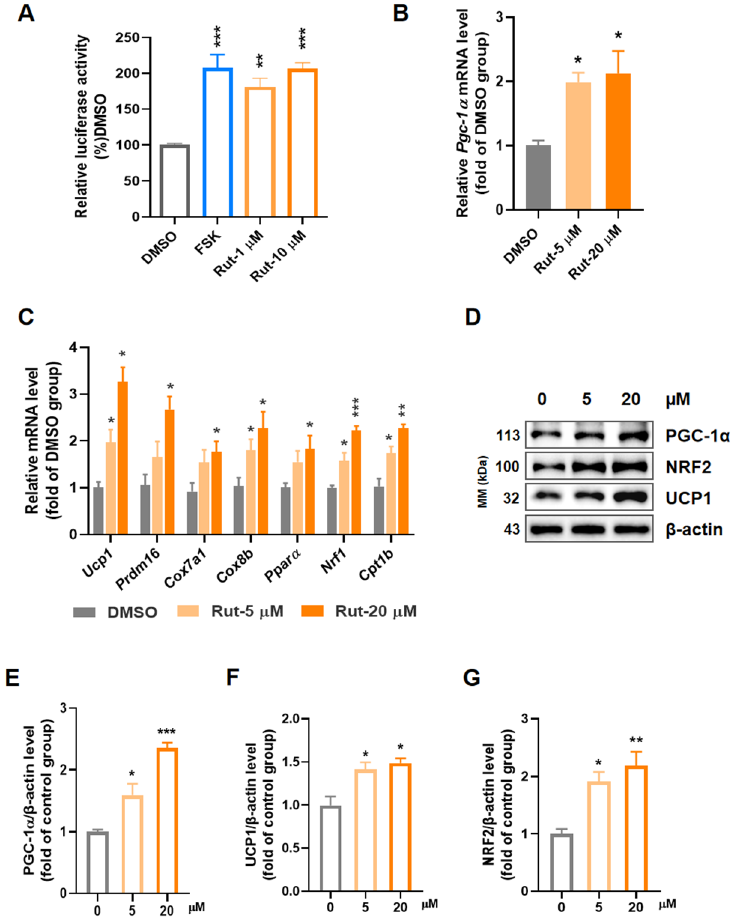
Figure 1. Rut increases expression of PGC-1 α and drives the thermogenesis program. ( A ) The screening result of Rut in activating PGC-1 α . ( B ) Effect of Rut on activating PGC-1 α in C3H10-T1/2. ( C ) RT-qPCR analysis of genes indicated in C3H10-T1/2. ( D ) Expressions of protein indicated in C3H10-T1/2 treated by Rut for 24 h. ( E – G ) Relative protein level of PGC-1 α ( E ), UCP1 ( F ) and NRF2 ( G ) compared to β -actin. n = 3 per group. Data are presented as the means ±SEM. * p < 0.05, ** p < 0.01, *** p < 0.001, Rut groups versus vehicle group by one-way ANOVA.